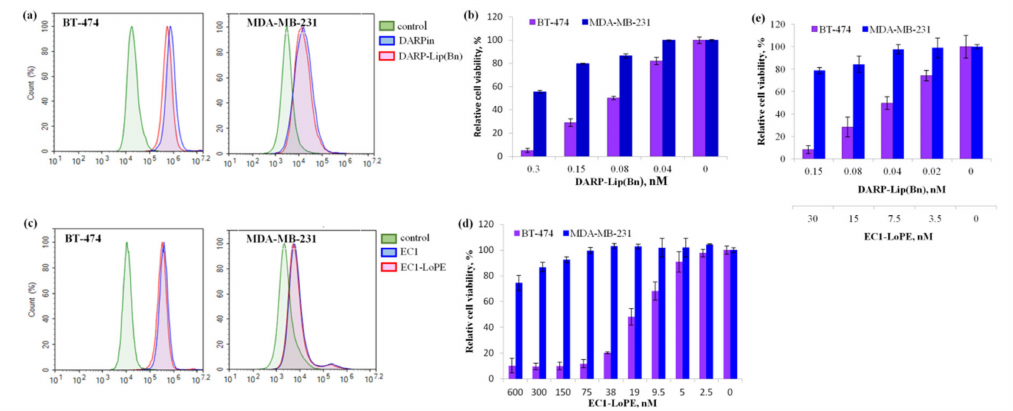
Figure 2. In vitro characteristics of DARP-Lip(Bn) and EC1-LoPE. ( a , c ) Normalized flow cytometry histograms showing specific interaction of DARP-Lip(Bn) and EC1-LoPE with HER2 and EpCAM receptors respectively. ( b , d ) In vitro cytotoxicity of DARP-Lip(Bn) and EC1-LoPE respectively. ( e ) Combined treatment of cells with DARP-Lip(Bn) and EC1-LoPE. Statistical analyses were performed using one-way analysis of variance (ANOVA). p < 0.01 versus control cells. Bars indicate SD for 3 independent